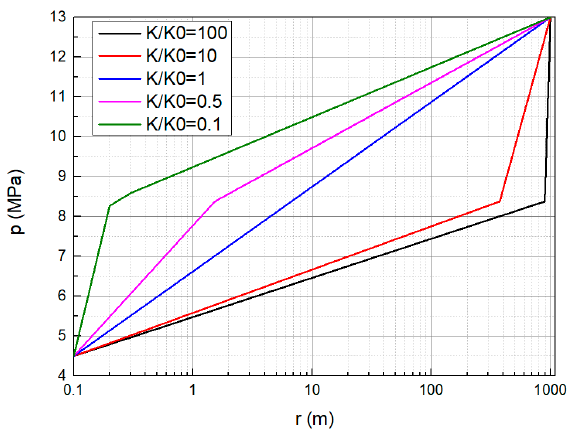
Figure 3. The diagram of pore-pressure distribution in hydrate formations in the case of constant well pressure.